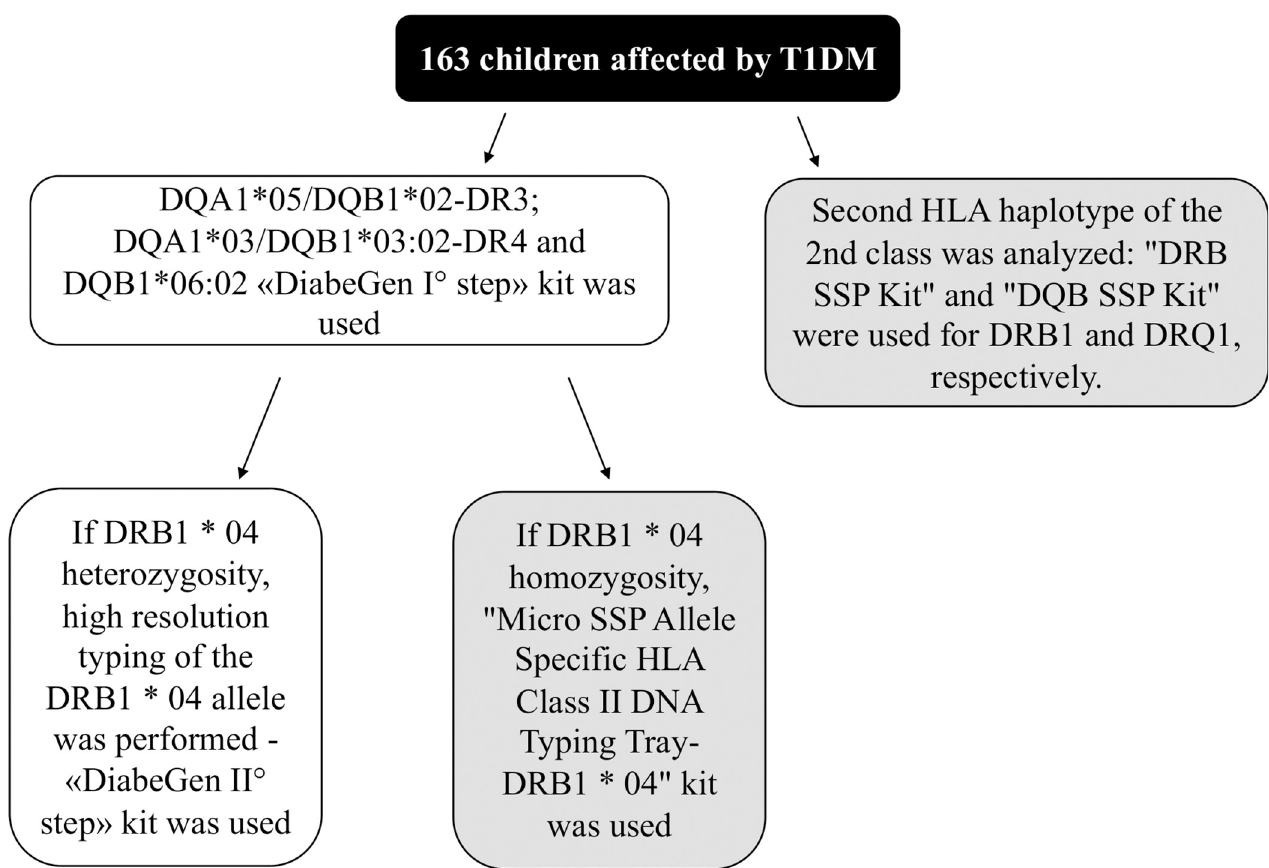
Fig 1. Flow chart of performed HLA class II typing in T1DM population. In white the routinary steps based on “Eurospital Diabegen I and II step”; in gray the added specifc study-steps based on PCR SSP (Sequence Specific Primers) technique.